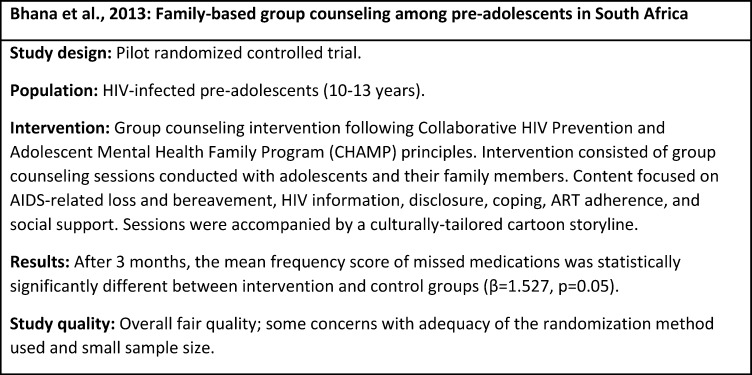
Bhana et al., 2013.